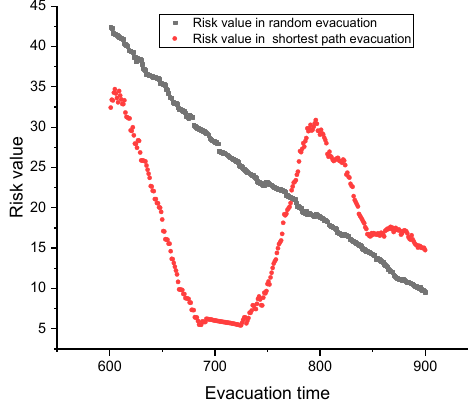
Figure 6. Pedestrian risks under two evacuation methods.